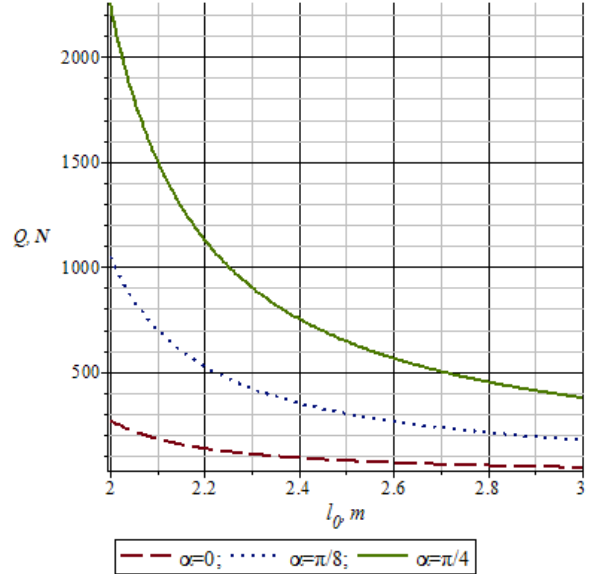
Figure 8. Graph of changes in the pressure of the working rolls depending on the length of the lever l 0 .